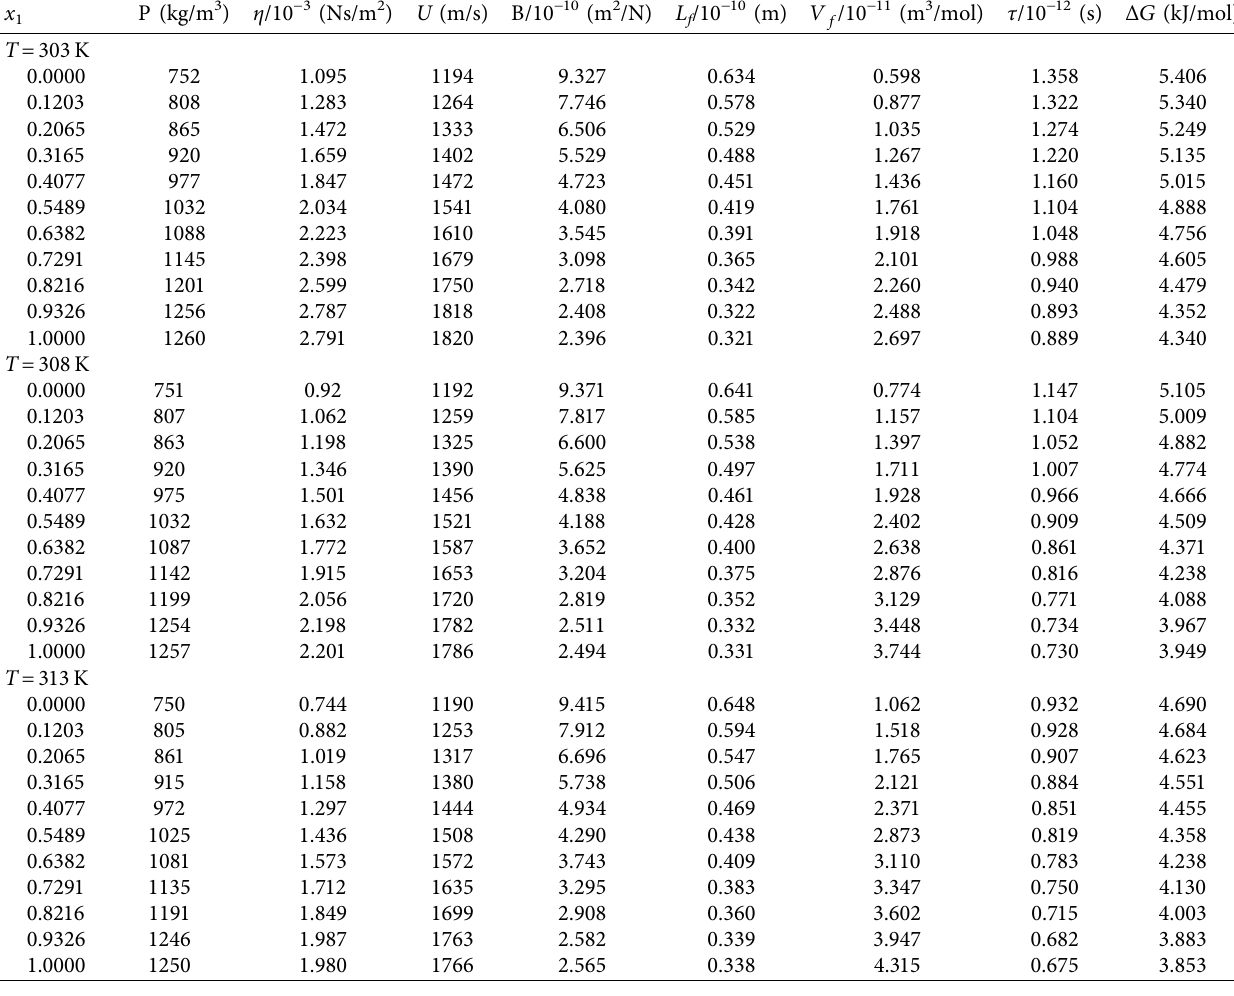
1 ) and 1-propanol ( x 2 ) at 303K, 308K, and 313K in the atmospheric pressure.